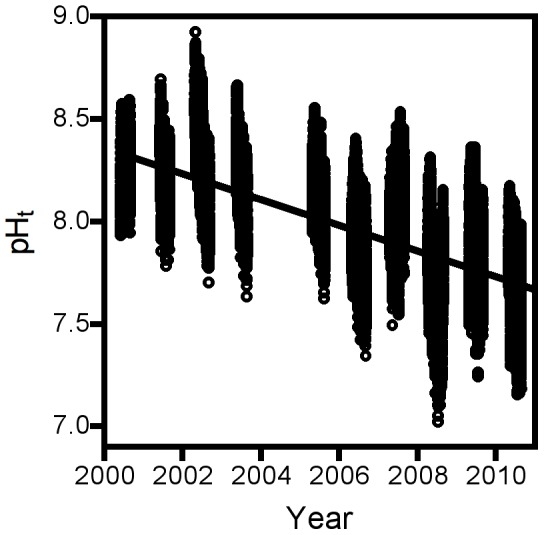
Trends in ocean pH taken from Tatoosh Island, Washington, from 2000–2010, expressed on the total scale.2004 not reported because of probe failure. N = 37,038.